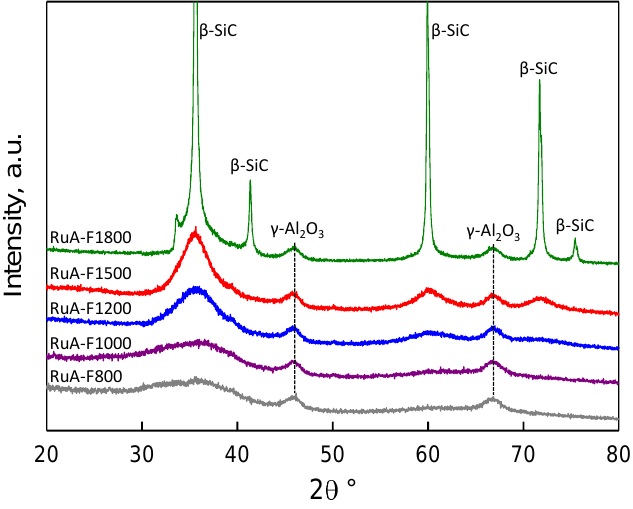
Figure 3. XRD patterns of RuA-F foam catalysts: RuA-F800 and -F1000 samples were only dried following impregnation with Ru; all other samples were further reduced in H 2 at 450 °C.